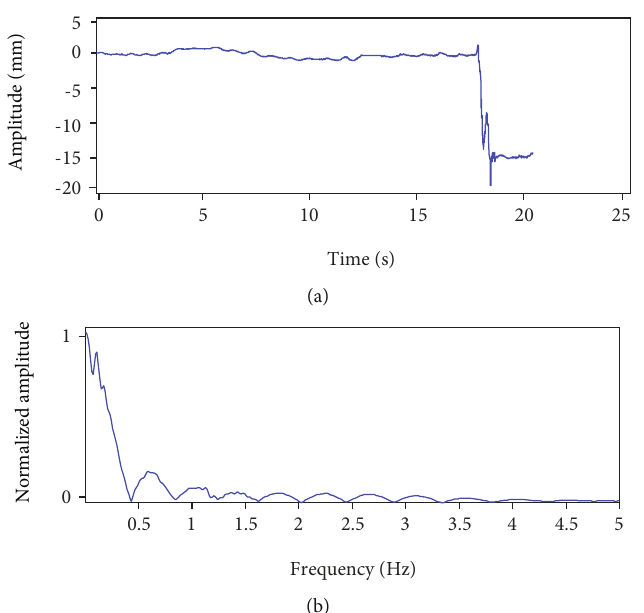
Figure 13: The demodulation result when using the multiple segments with di ff erent DC o ff set method. (a) In time domain. (b) In frequency